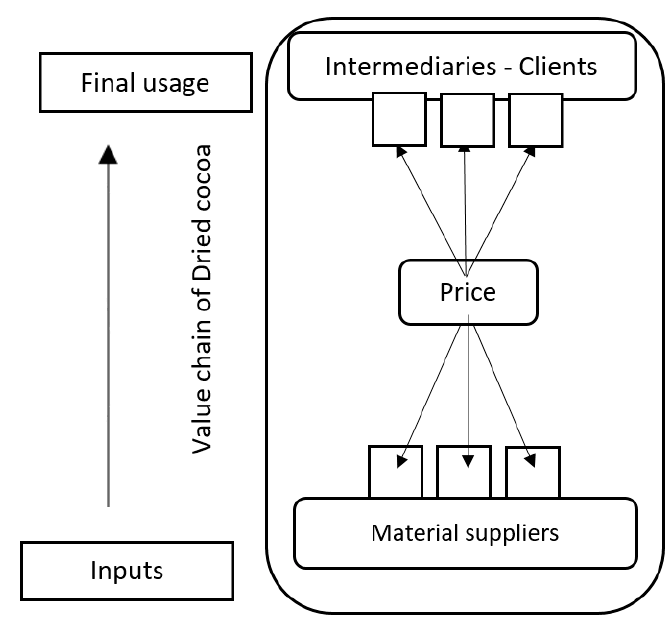
Figure 5. Governance mechanism at CCN-51 cacao chain.